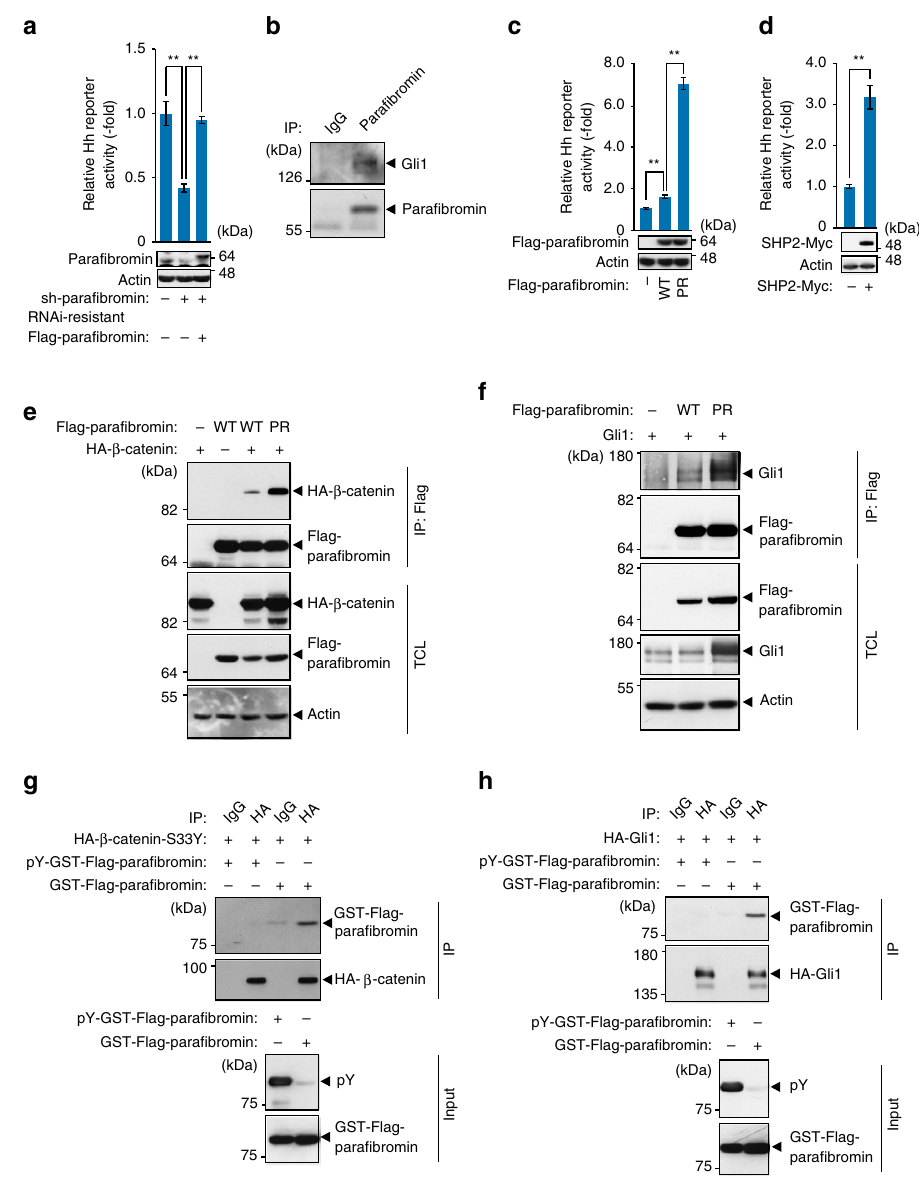
Figure 1 | Parafibromin transactivates Hedgehog signalling in a tyrosine dephosphorylation-dependent manner. ( a ) Parafibromin knockdown results in reduced Hh signal activity. Hh-responsive luciferase reporter assays were performed in HEK293T cells. Total cell lysates (TCLs) were subjected to immunoblotting ( n ¼ 3, mean ± s.d. ** P o 0.01; ANOVA with Bonferroni’s post hoc test). ( b ) Parafibromin interacts with Gli1. TCLs prepared from SKES cells were sequentially immunoprecipitated (IP) with an anti-parafibromin antibody and immunoblotted. ( c ) Phospho-resistant (PR)-parafibromin shows increased ability to activate Hh signalling. Hh-responsive luciferase reporter assays were performed in HEK293Tcells ( n ¼ 3, mean ± s.d. ** P o 0.01; ANOVA with Bonferroni’s post hoc test). ( d ) SHP2 expression promotes Hh signalling. Hh-responsive luciferase reporter assays were performed in A549 cells ( n ¼ 3, mean ± s.d. ** P o 0.01; a two-tailed unpaired Student’s t -test). ( e , f ) PR-parafibromin shows increased binding to b -catenin and Gli1. HEK293Tcells were transfected with the indicated vectors. TCLs were sequentially immunoprecipitated (IP) and immunoblotted. ( g , h ) Non-phosphorylated parafibromin specifically interacts with b -catenin and Gli1. HEK293Tcells were transfected with the indicated vectors. TCLs were immunoprecipitated with the indicated antibodies and immunoprecipitates (IP) were incubated with recombinant phosphorylated/non-phosphorylated parafibromin. The reaction mixtures were subjected to immunoblotting.